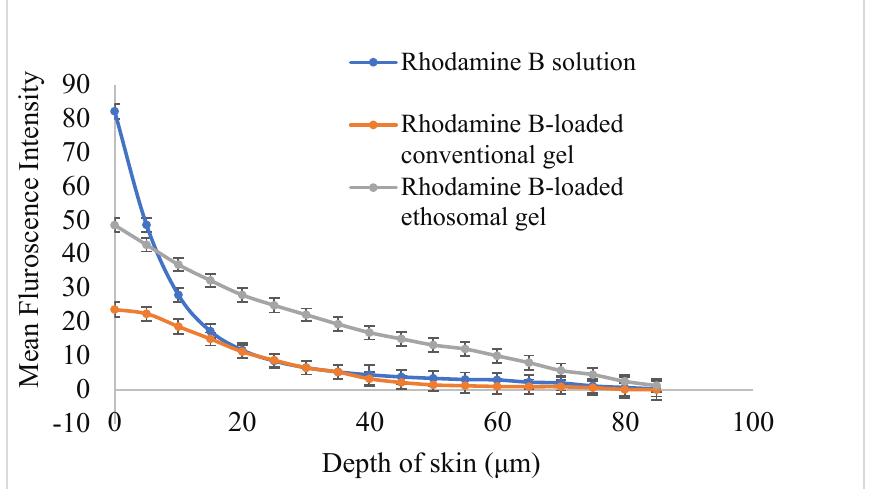
Figure 14. Comparative CLSM plots between the mean fluorescence intensity produce by rhodamine dye and depth of skin permeation after treating the skin with rhodamine B solution, rhodamine B-loaded conventional gel and rhodamine B-loaded ethosomal gel.